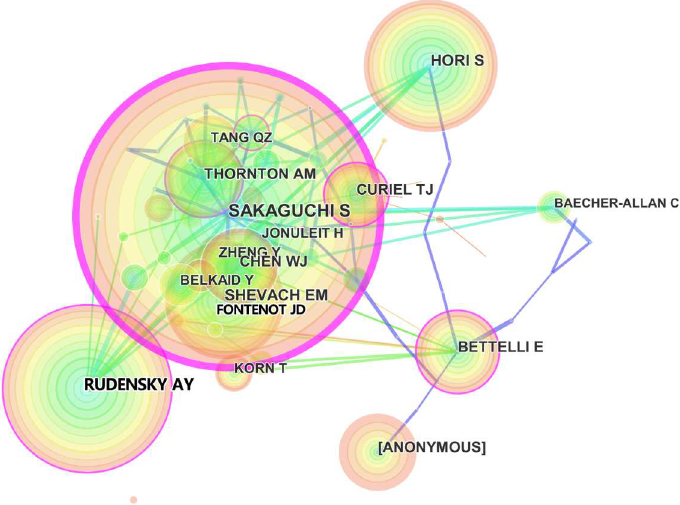
Fig 5. Co-citation map of authors who published articles related to regulatory T cell (Treg) research from 2000 to